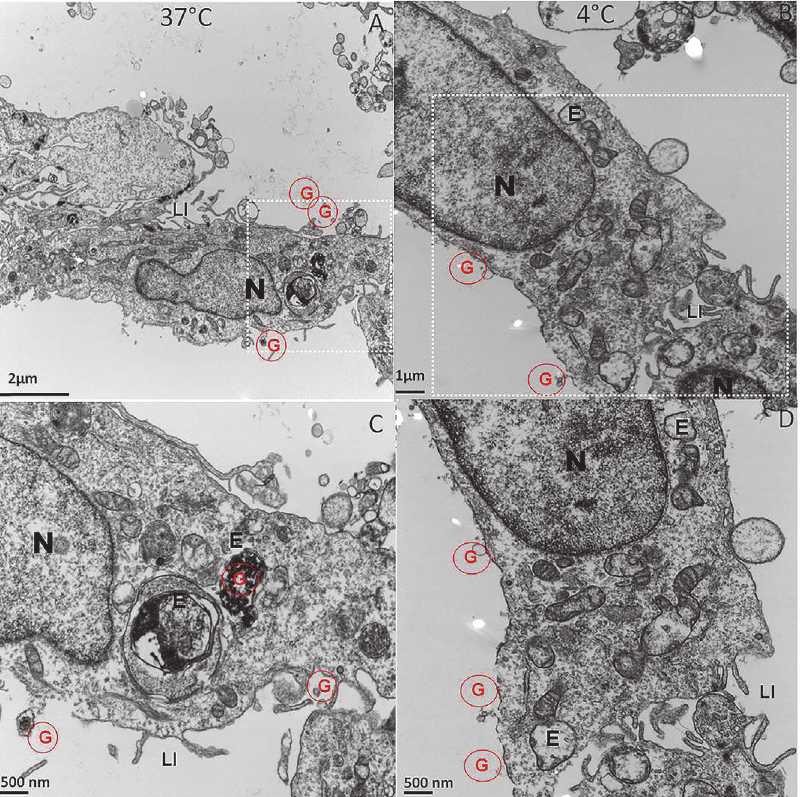
Fig 2. TEM micrographs showing endocytosis mediated uptake of liposome encapsulated gold marker at 37°C (Panel A&C). Higher magnification image of inscribed area from panel A showed that vesicle like structures in endosomal compartment (marked by E) contained cluster of electron dense dark particles inside a single cell (Panel C). In contrast, only extracellular binding of liposomes containing dark grains was observed at 4°C (Panel B) and corresponding higher magnification image (Panel D) showed that vesicle like structures in a single cell were devoid of dark gold particles, which indicates absence of internalization due to temperature dependent inhibition of endocytosis. Gold encapsulated in liposomes is marked by red colored G inside a red circle, nucleus is marked by N, endocytic vesicles are marked by E and finger like projections called as lateral interdigitation are marked by LI. Inscribed area of panel A and B in white rectangle is magnified further in panel C and D, respectively and magnification is shown by scale bar in each panel.